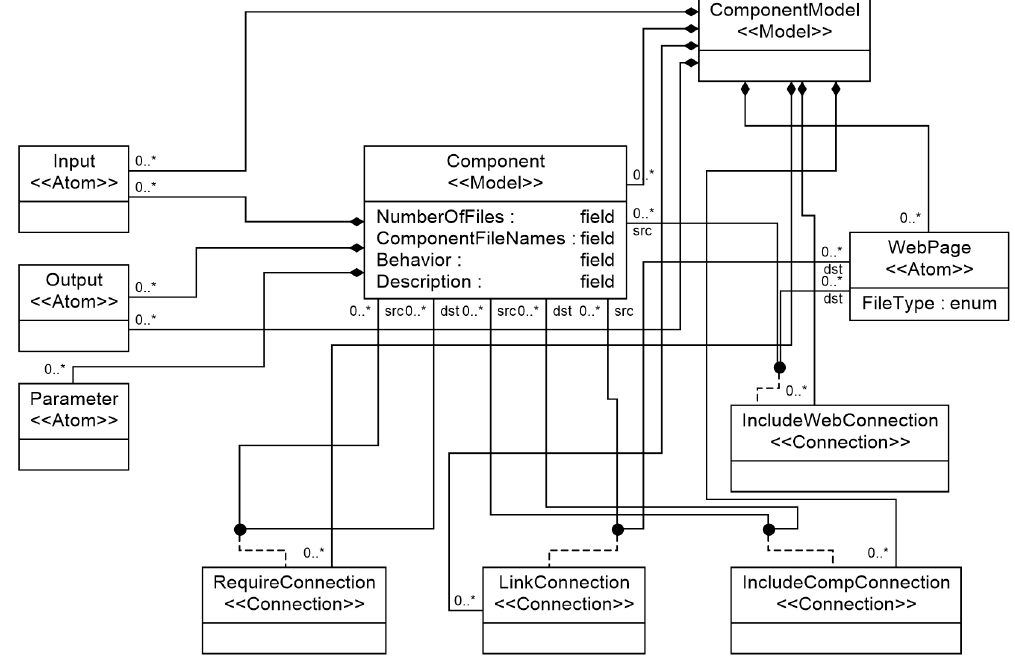
Figure 6. CPImeta: component platform independent